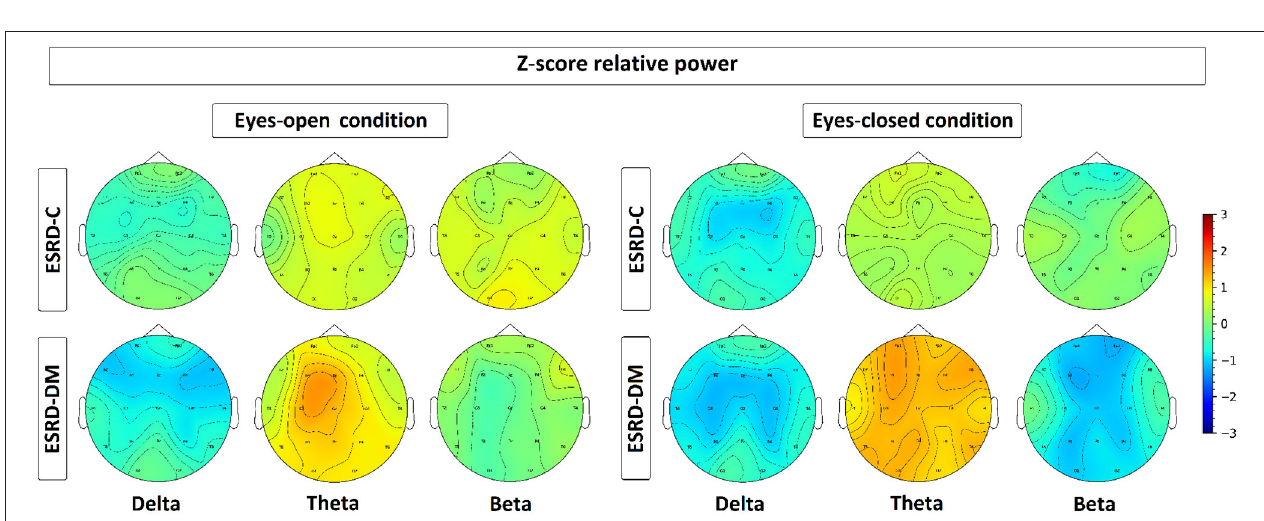
FIGURE 2 | Global Z-scores of relative power in the ESRD-C and ESRD-DM groups was globally found to be different in delta, theta and beta as denoted by check mark. Comparing to healthy control, consistent trend of low delta and high theta was noticeably appeared in both eyes-closed/open condition in ESRD-C (blue) and ESRD-DM (orange) as signified by arrows. P -values were calculated by Mann–Whitney U -test. The color bar represents IQR, and whiskers were set at an IQR of 1.5. Gray arrow refer to deviation from healthy control in both subject groups.